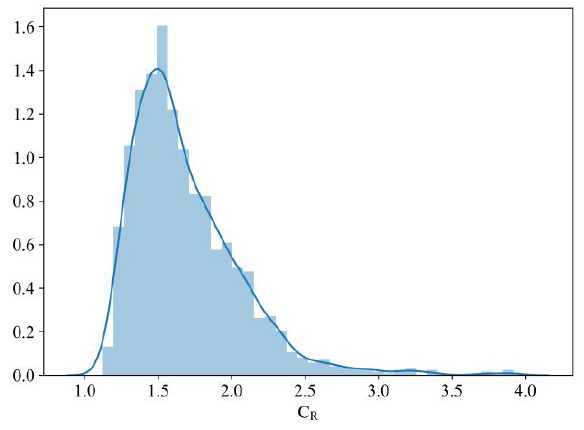
Figure 8. Theoretical bounds of Shannon’s theorem and the scatter plot of H against C R obtained by JPEG-LS